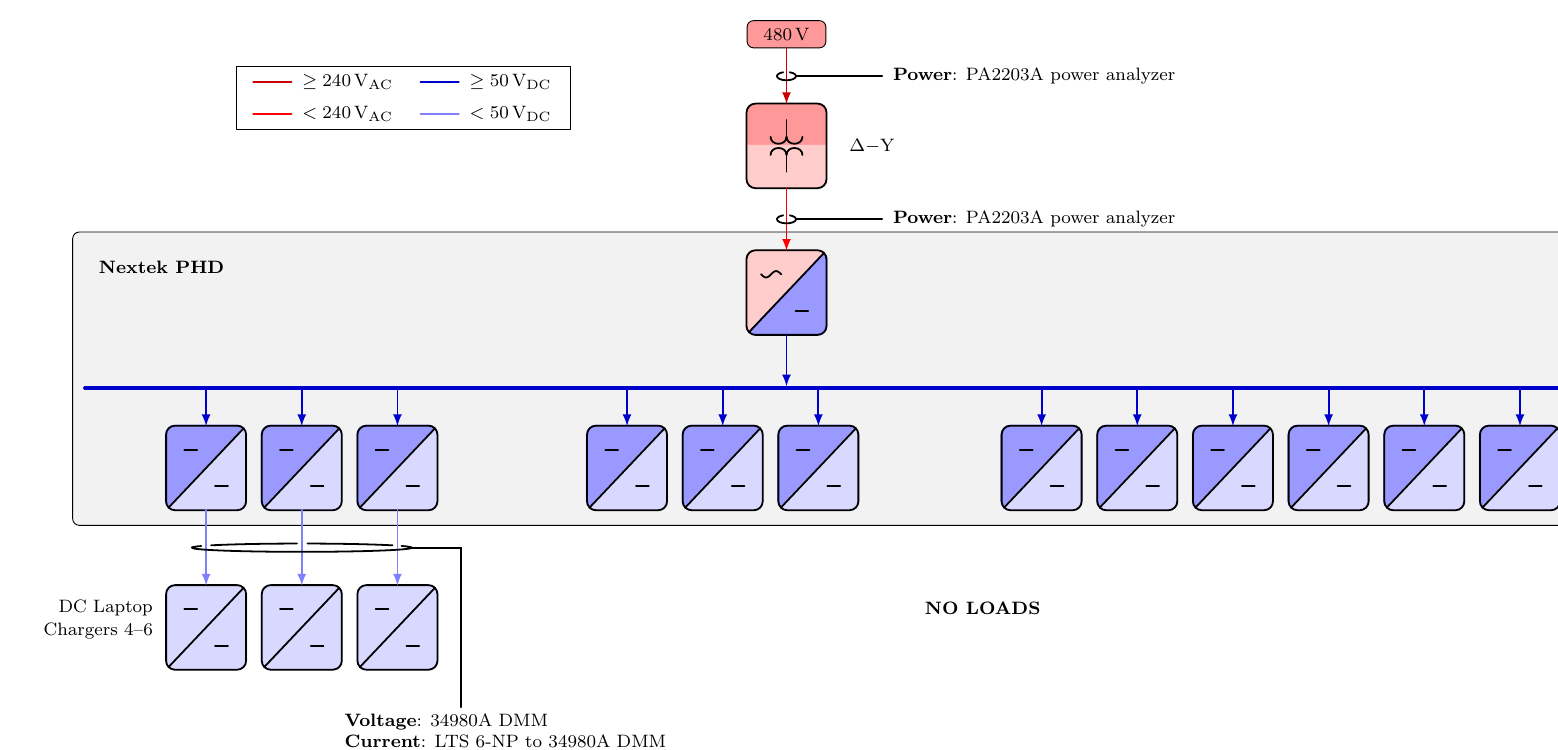
Figure A4. Electrical diagrams for Scenarios 5.1 and